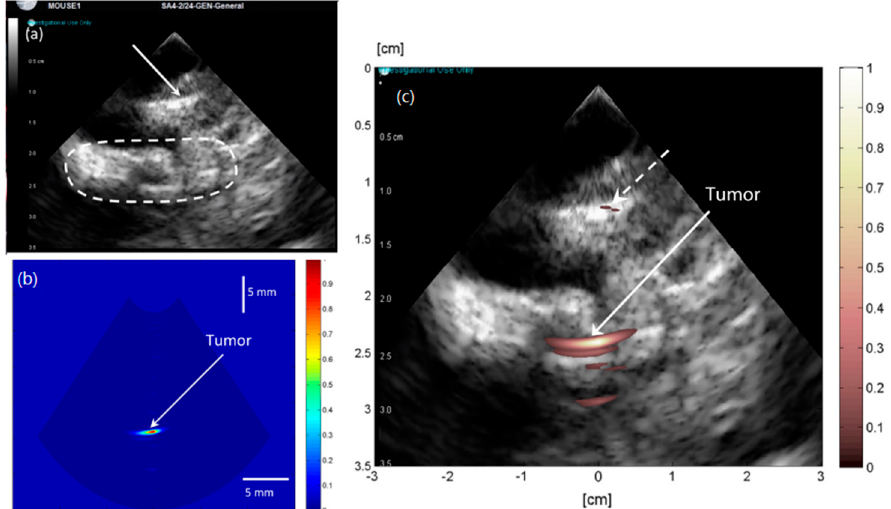
Figure 15. ( a ) Pure ultrasound image showing the bottom edge of the plastic seat (arrow) and region of interest (oval); ( b ) improved post-amplification PA image of tumor in right thigh of nude mouse. ( c ) Improved filtered PA image superimposed on the pure ultrasound image of the right thigh of the mouse. Reproduced with permission from Ref. [94].